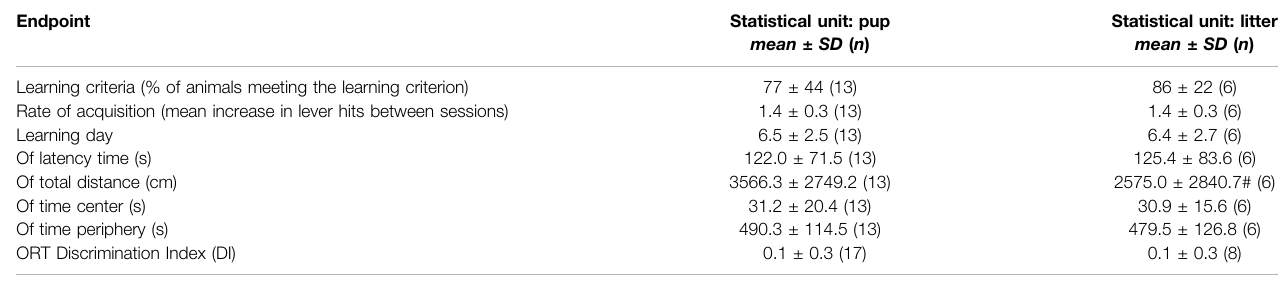
Statistical unit: litter mean ± SD ( n )